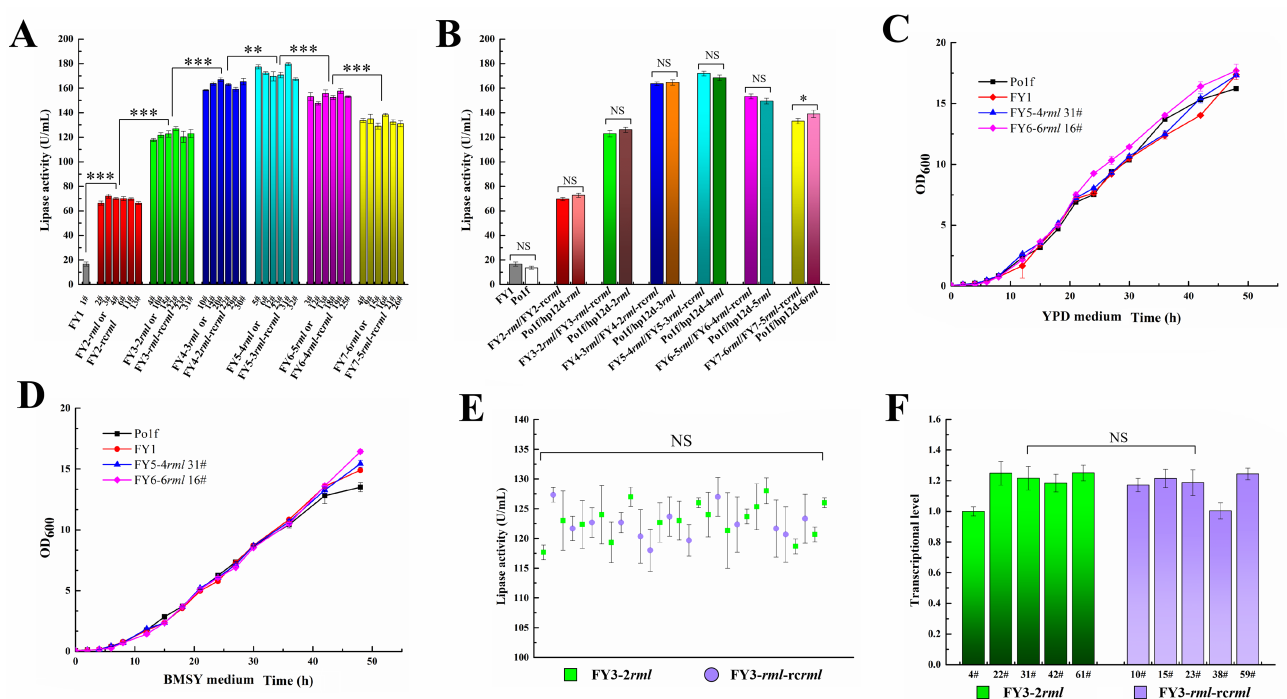
Figure 4. ( A ) Lipase activity of recombinant strains harboring different copies of rml expression cassettes. ( B ) Comparison of lipase activity of recombinant strains obtained via different methods. Data are the mean values of each kind of recombinant strain. The strains Po1f and FY1 show low lipase activity owing to expression of autologous lipase genes. Weakly significant difference is observed between the strains FY7-6 rml /FY7-5 rml -rc rml and Po1f/hp12d-6 rml ( p = 0.044). ( C ) Lipase activity of transformants from third-round integration. ( D ) Transcriptional level analysis of rml mRNA from FY3-2 rml and FY3- rml - rc rml . The endogenous act1 was adopted as a reference gene, and the rml transcriptional level of FY3-2 rml 4# was defined as 1. ( E ) Growth curves of Po1f, FY1, FY5-4 rml 31#, and FY7-6 rml 13# in YPD medium. ( F ) Growth curves of Po1f, FY1, FY5-4 rml 31#, and FY7-6 rml 13# strains in BMSY medium. NS, *, **, and *** indicate non-significant, p < 0.05, p < 0.01, and p < 0.001,